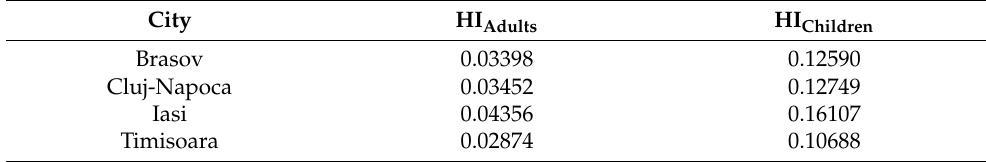
Table 6. Health risk index calculated for each city.